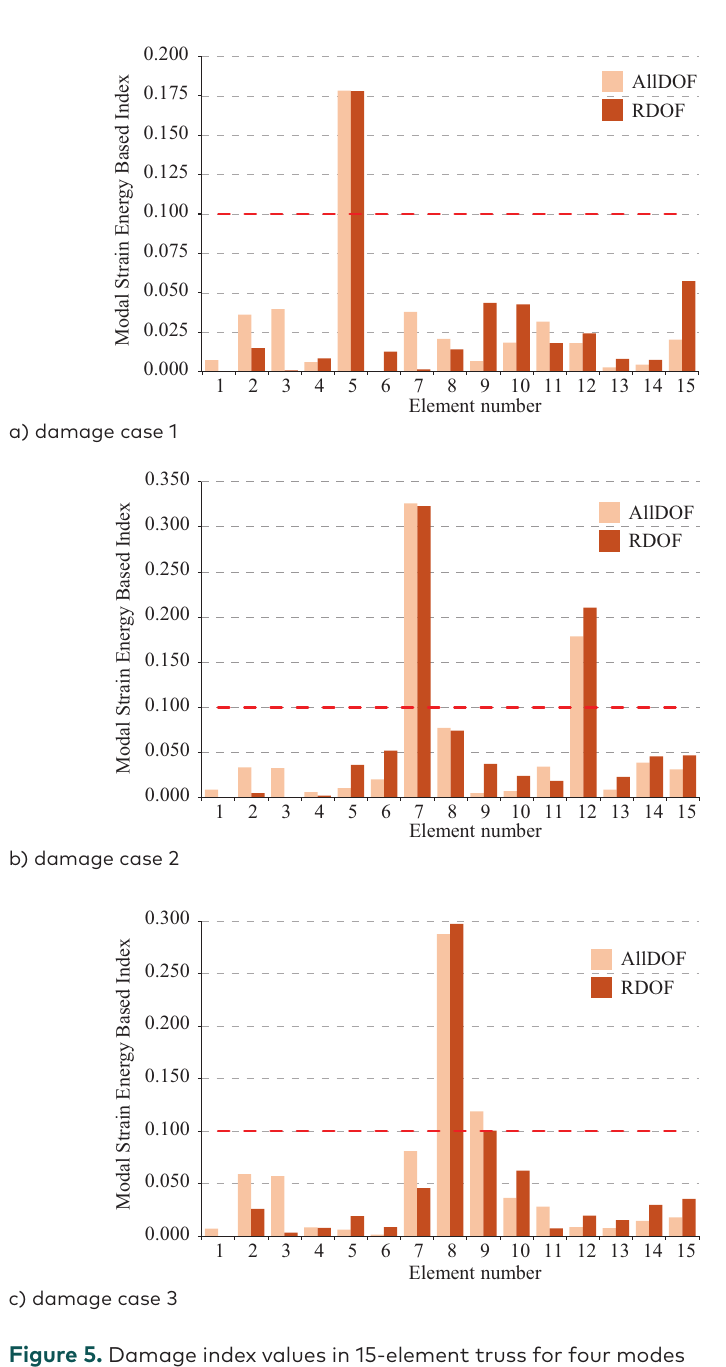
Figure 5. Damage index values in 15-element truss for four modes with 3%